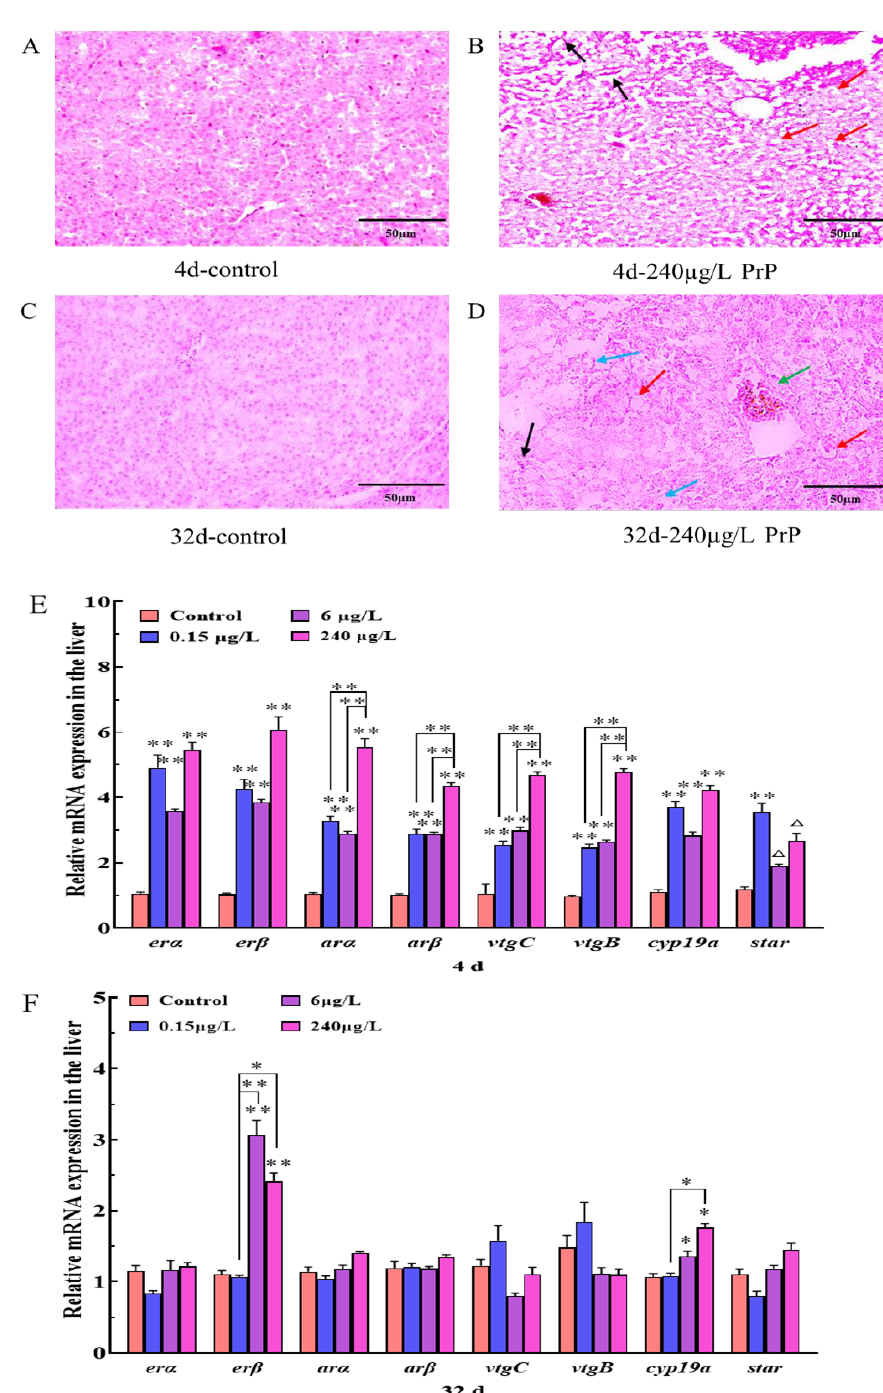
Figure 2. Histological appearance of hepatocytes in the liver of male mosquitofish from the control (( A ): 4d and ( C ): 32d) and PrP-severely affected group (240 µ g/L PrP) (( B ): 4d and ( D ): 32d). Bars = 50 μm, n = 20. Black arrows: hepatic sinus dilatation; Red arrows: cytoplasmic vacuolation; Blue arrows: cytolysis; Green arrows: nuclear aggregation. ( E ) and ( F ): transcriptional levels of HPGL axis related genes in the liver of male mosquitofish suffered from 0, 0.15, 6 and 240 μg/L PrP treat- ment for 4d ( E ) and 32d ( F ), respectively. Data were analyzed by t -test and Tukey ’s multiple com- parisons. Asterisks (*) above the bars indicate statistical significance (* p <0.05, ** p <0.01, △ p < 0.08). er α , estrogen receptor alpha; erβ , estrogen receptor beta; arα , androgen receptor alpha; arβ , androgen receptor beta; vtgB , vitellogenin B; vtgC , vitellogenin C; cyp19a , cytochrome P450, family 19, sub- family A; star , steroidogenic acute regulatory protein.